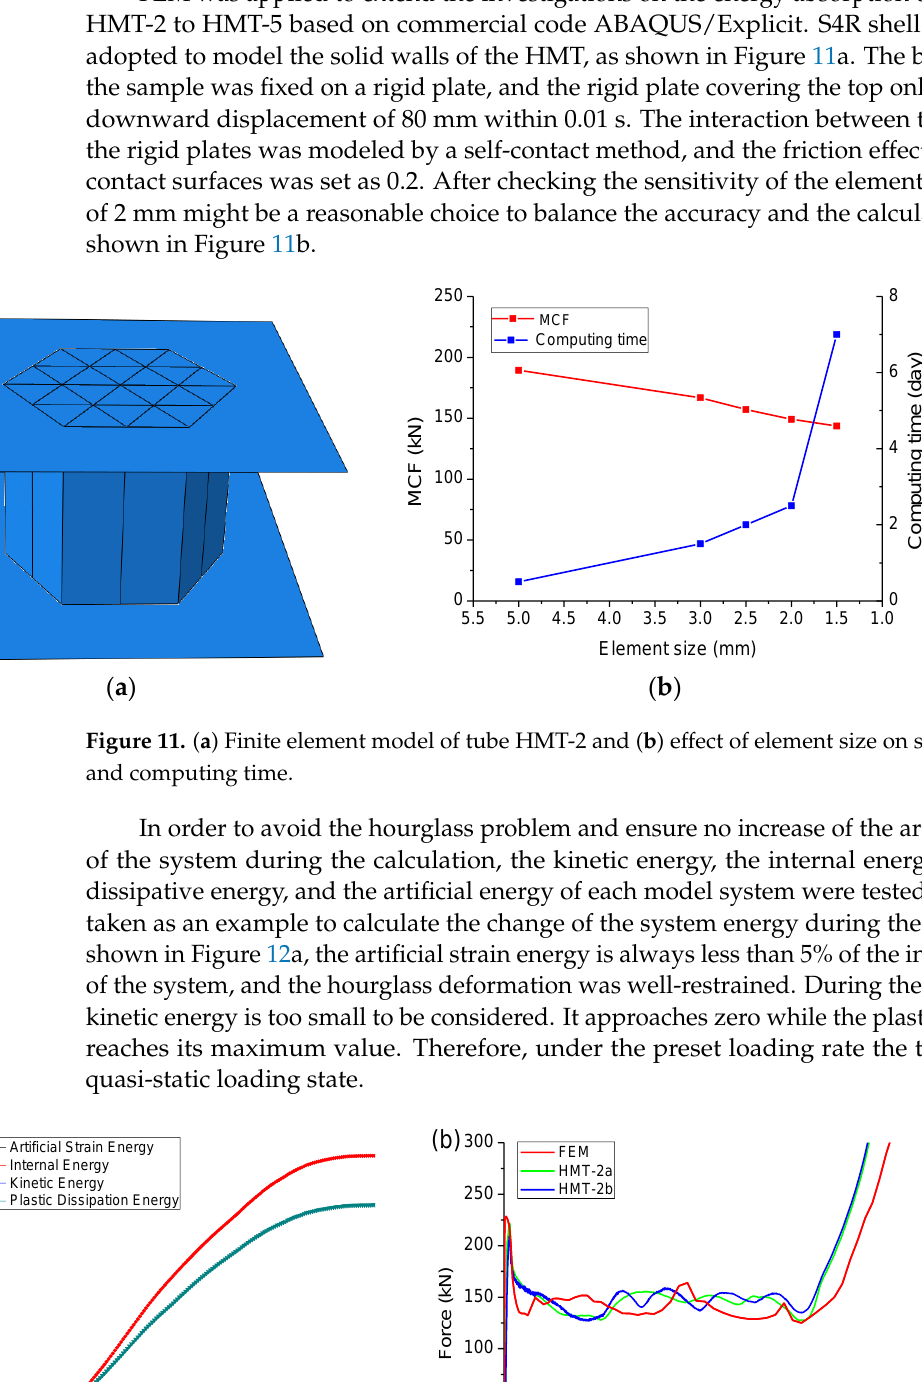
Table 6. Comparisons between FEM and experiments.